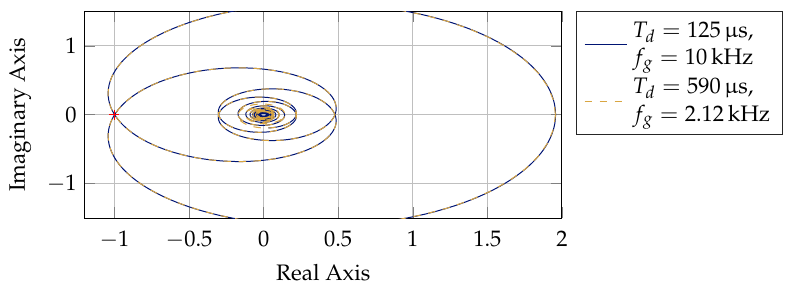
Figure 13. Locus plot of voltage type ITM PHiL with different loop time delays and low pass cut of frequencies.